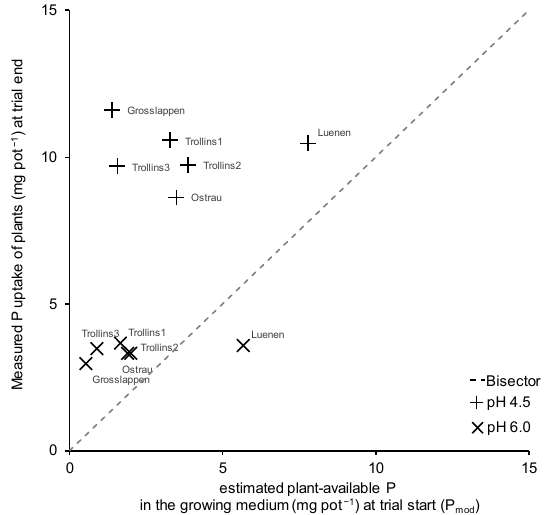
Bisector pH4.5 pH6.0 estimated plant-available P estimated plant-available P in the growing medium (mg pot −1 ) at trial start (P mod ) in the growing medium (mg pot −1 ) at trial start (P mod ) Figure 6. Relationship of the measured phosphorus (P) uptake of marigold plants four weeks after Figure 6. Relationship of the measured phosphorus (P) uptake of marigold plants four weeks Figure 6. Relationship of the measured phosphorus (P) uptake of marigold plants four weeks after fertilization with different sewage sludge ashes (Trollins1, Trollins2, Trollins3, Ostrau, Luenen, fertilization with different sewage sludge ashes (Trollins1, Trollins2, Trollins3, Ostrau, Luenen, after fertilization with different sewage sludge ashes (Trollins1, Trollins2, Trollins3, Ostrau, Luenen, Grosslappen) and cultivation in growing media of contrasting pH to the estimated amount of plant- Grosslappen) and cultivation in growing media of contrasting pH to the estimated amount of plant- Grosslappen) and cultivation in growing media of contrasting pH to the estimated amount of plant- available P by the model accoring to Hauck et al. [23] in the growing medium at the trial start based available P by the model accoring to Hauck et al. [23] in the growing medium at the trial start based available P by the model accoring to Hauck et al. [23] in the growing medium at the trial start based on P CAT and P CAL . on P CAT and P CAL . on P CAT and P CAL